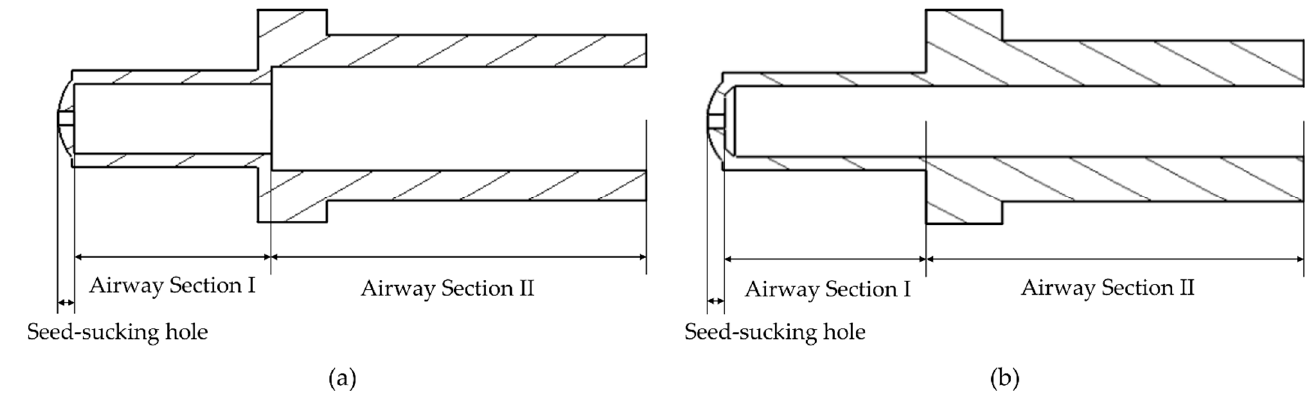
Figure 3. Sectional view of the variable-section panhandle area: ( a ) the section with an unequal diameter; ( b ) the section with an equal diameter.